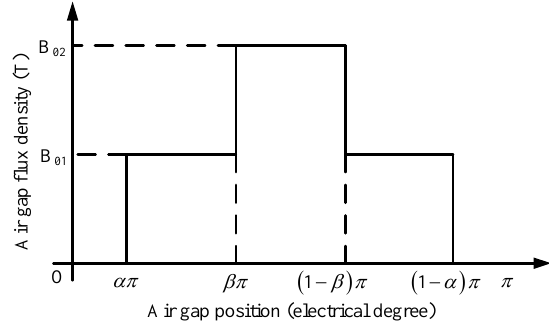
Figure 9. Idealized air gap flux density waveform at no-load.